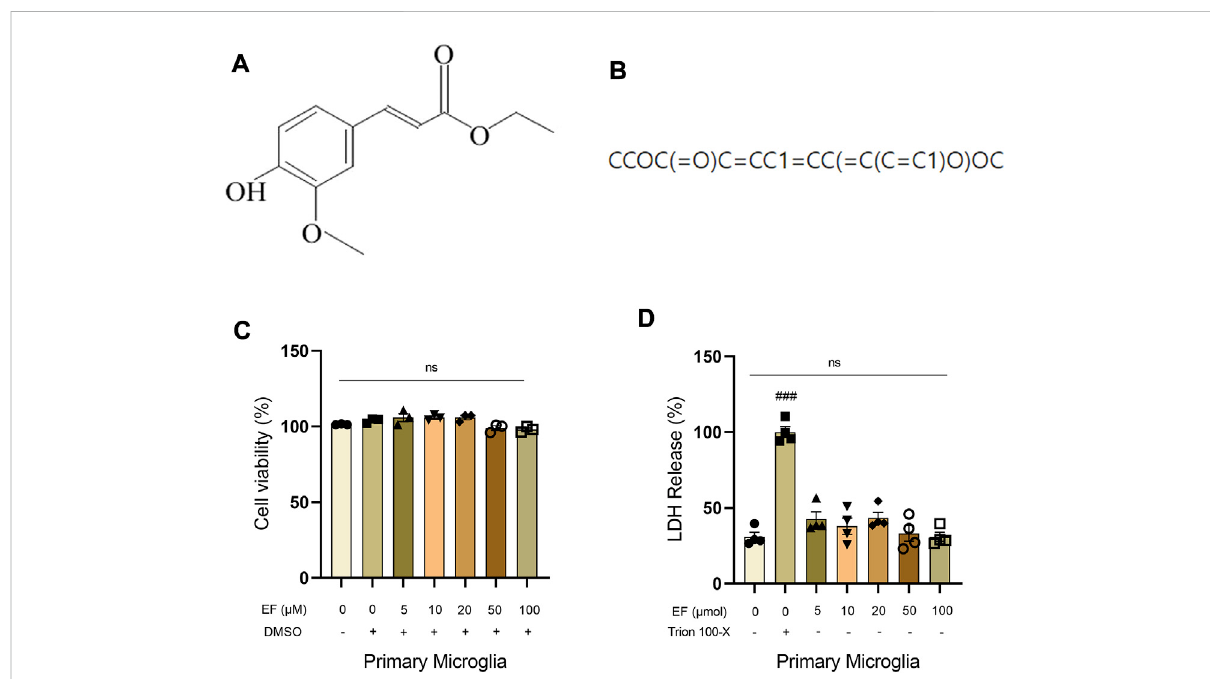
FIGURE 1 EFisblood-brain barrier permeable without observablecytotoxicity. (A) Chemical structureofEF. (B) Canonical SMILES computedbyOEChem 2.3.0 (PubChem release 2021.05.07). (C,D) Primary microglia were treated with/without EF in a dose-dependent manner (0, 5, 10, 20, 50, 100 μ mol) for24 h,thenCCK-8assayandLDHcytotoxicityassaywasaddedtodetectcellviability,respectively.Valuesarepresentedasmeans±SEM, n =3 – 4/ group. ### p < 0.0001 compared with control. ns represented no signi fi cant statistical difference. Comparison was from at least three independent